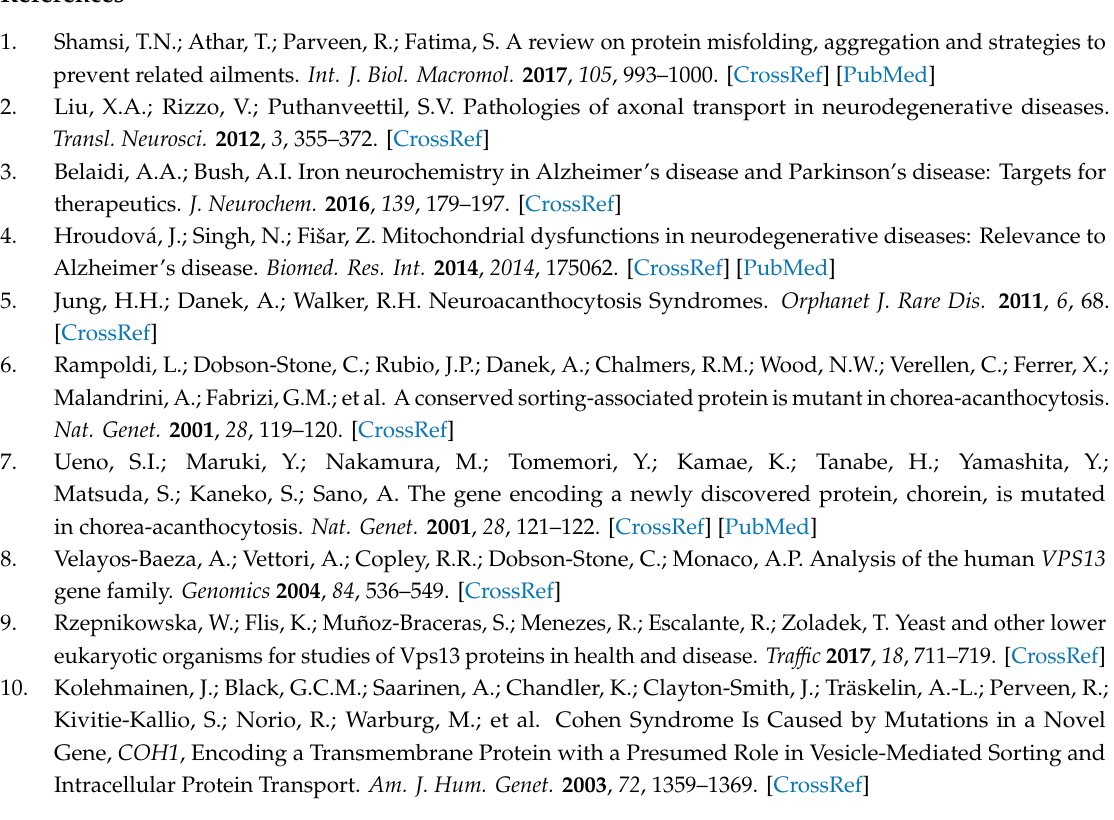
Figure S1: Comparison of chemical suppressors of vps13 ∆ growth defect upon SDS stress; Figure S2: Comparison of the action of flavonoids on wild-type and vps13 strains upon cadmium stress; Figure S3: Signaling pathway involving FET3 and CTH2 genes responding to iron deficiency is not activated in vps13 ∆ cells; Table S1: List of S. cerevisiae strains used; Table S2: List of chemical compounds used; Table S3: List of plasmids